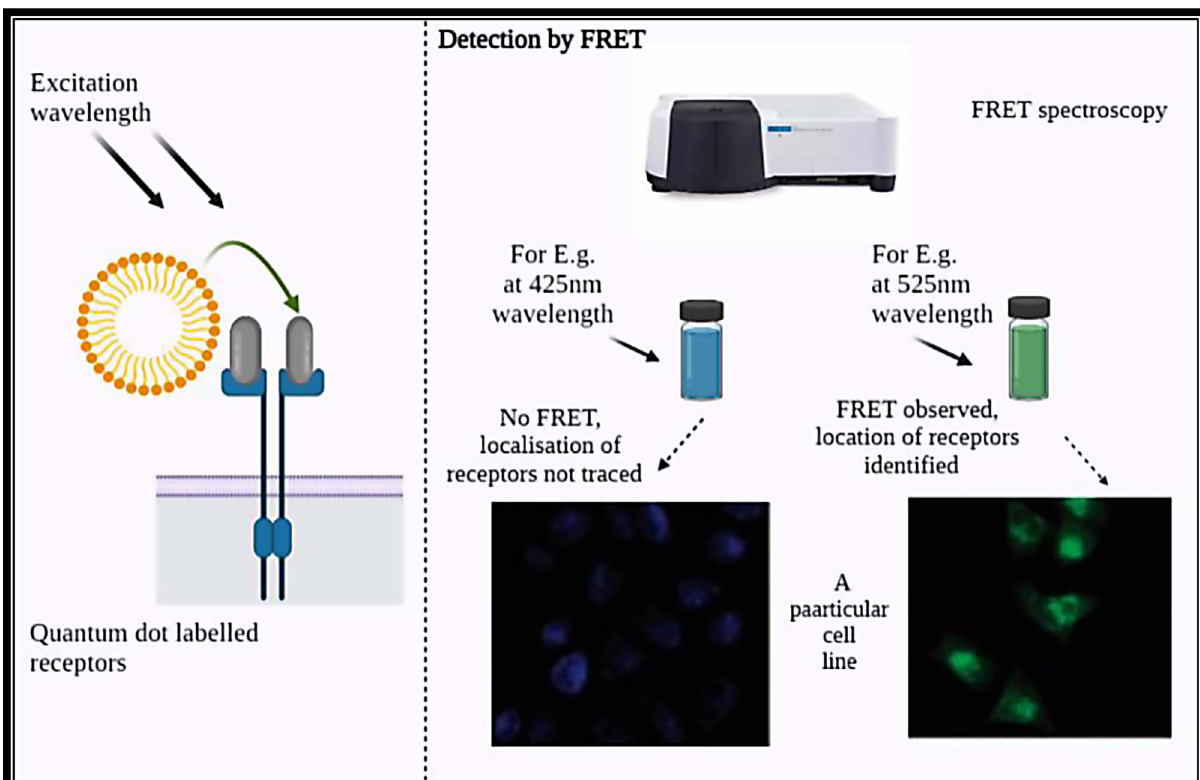
Figure 3. Quantum dots and their application in FRET